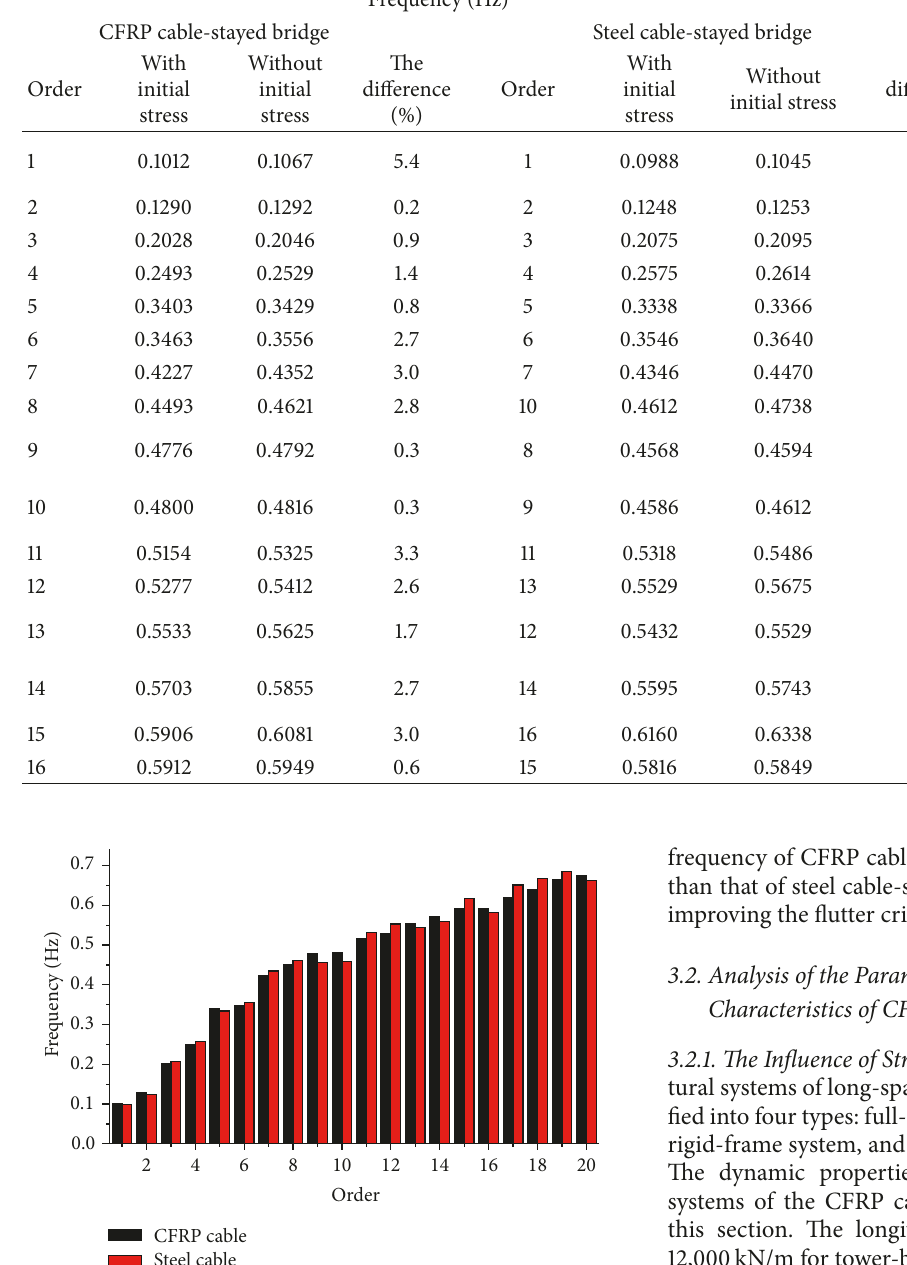
characteristicsCFRP cable-stayed bridge